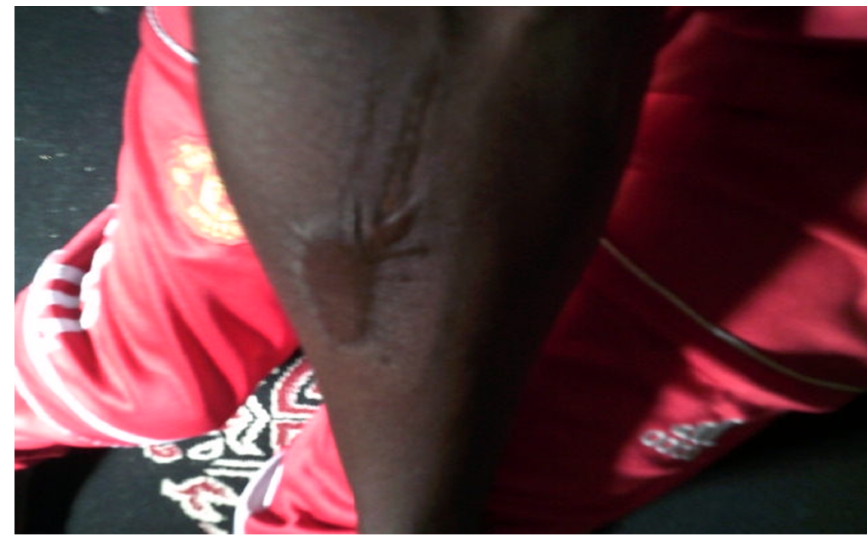
Figure 8. A scar on the participant’s hand from a homophobic attack in his